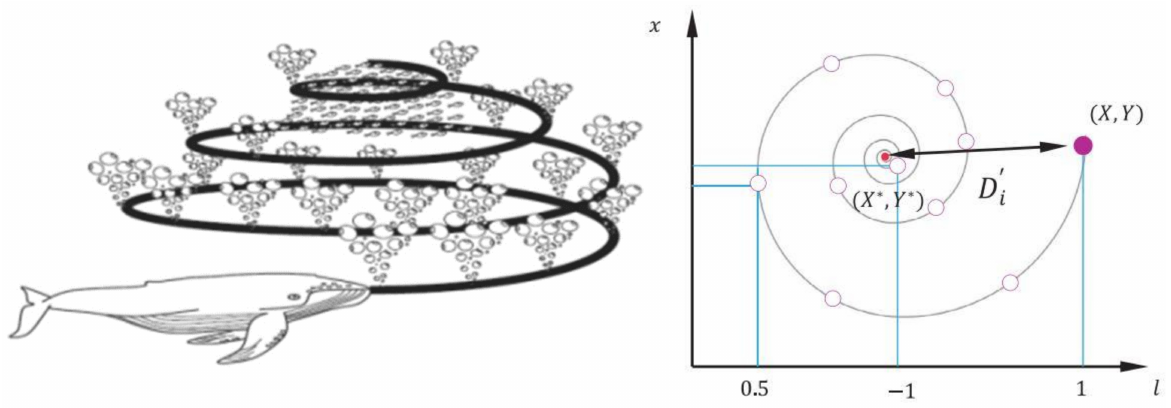
Figure 4. The bubble-net mechanism in the whale optimization algorithm